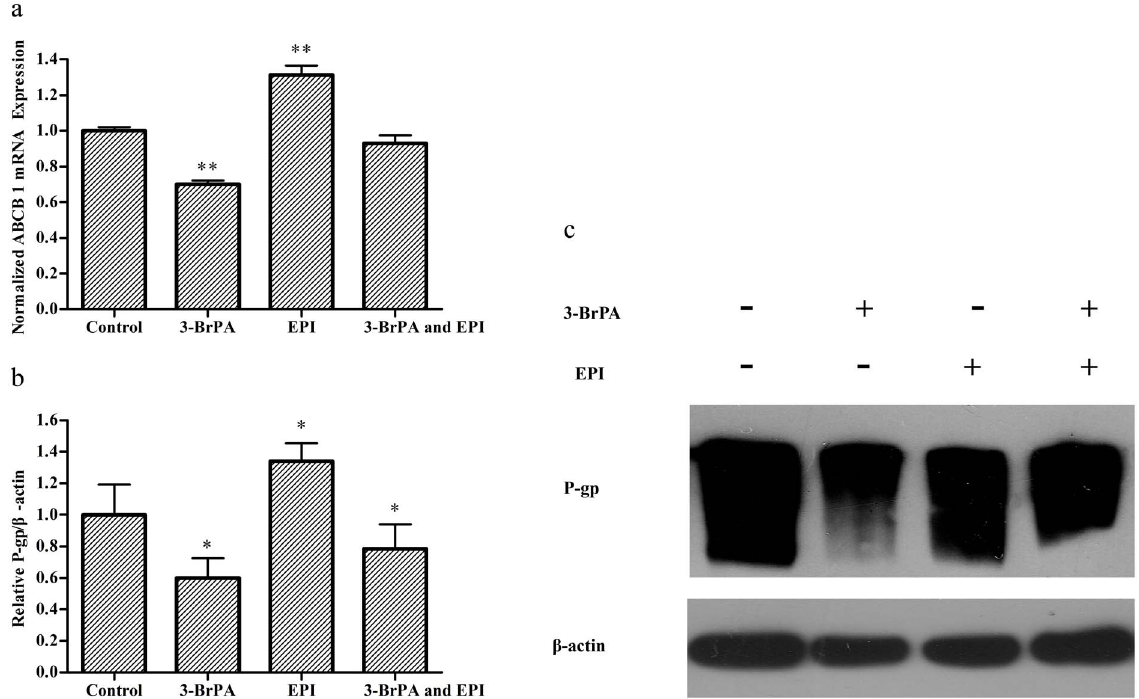
Figure 9. ABCB-1/P-gp expression changes caused by 3-BrPA invivo. a: The mRNA level of ABCB-1 in MCF-7/ADR tumor tissue treated with different groups was determined by real-time PCR, b -actin served as internal controls for real-time PCR respectively. b, c: The protein expression level of P-gp in MCF-7/ADR tumor tissue treated with different groups was determined by Western blotting analysis, b -actin served as internal controls Western blotting, respectively. * P , 0.05 compared with the control, ** P , 0.01 compared with the control.